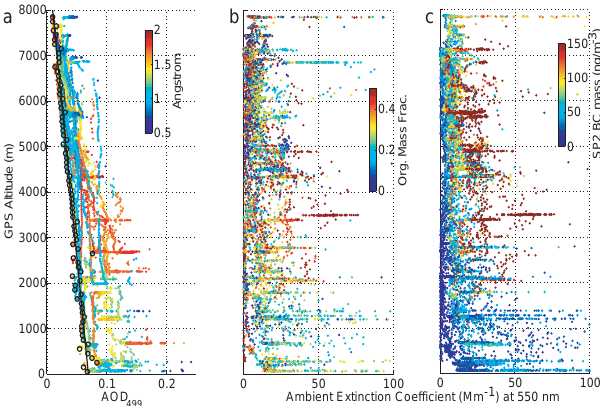
Fig. 2. Vertical profiles of AOD at 499nm (a) and ambient extinc- tion coefficient (Mm − 1 ) at 550nm (b, c) color-coded with (a) the AOD ˚Angstr¨om exponent at 499nm, (b) organic fraction of non- refractory mass of submicron particles and (c) the black carbon mass at standard temperature and pressure, for the Alaska phase. These data from 1–15 April 2008 are averaged over 3s for (a) , 10s for (b) and (c) . In (a) the 5th percentile in each 100-m altitude bin is marked with circle, and its linear regression with black